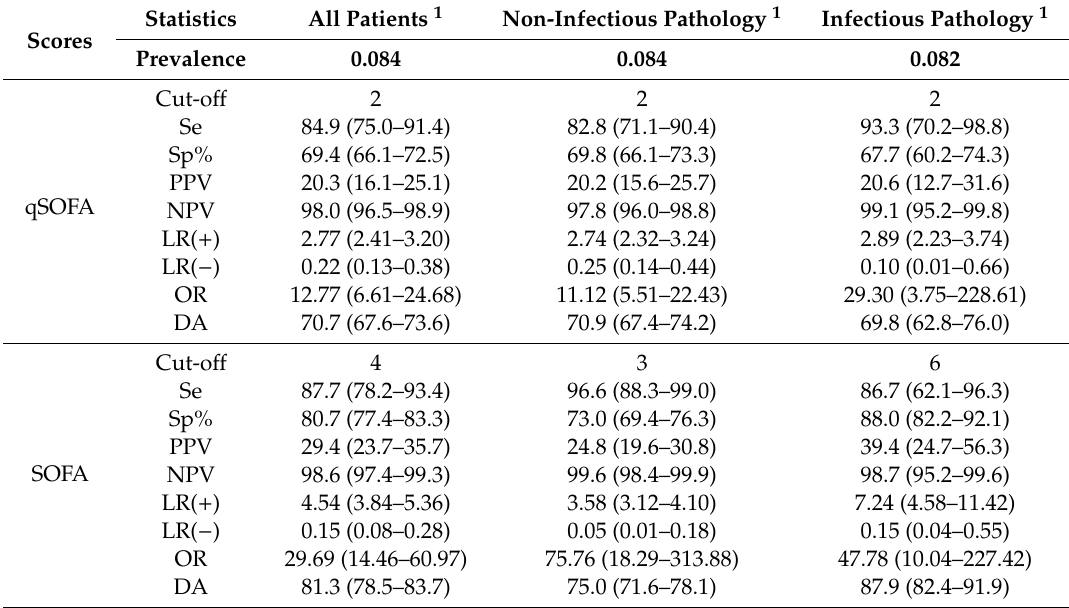
Table 4. Cut-o ff points for combined sensitivity and specificity with the best score (Youden’s test) on the qSOFA and SOFA for two-day